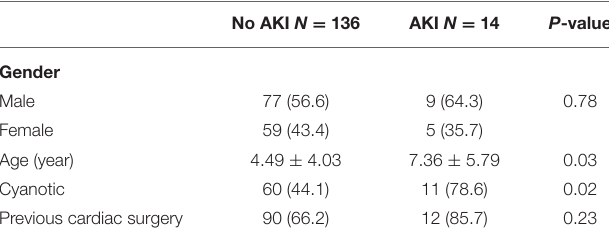
TABLE 1 | Demographic data and patient characteristics ( N = 150).